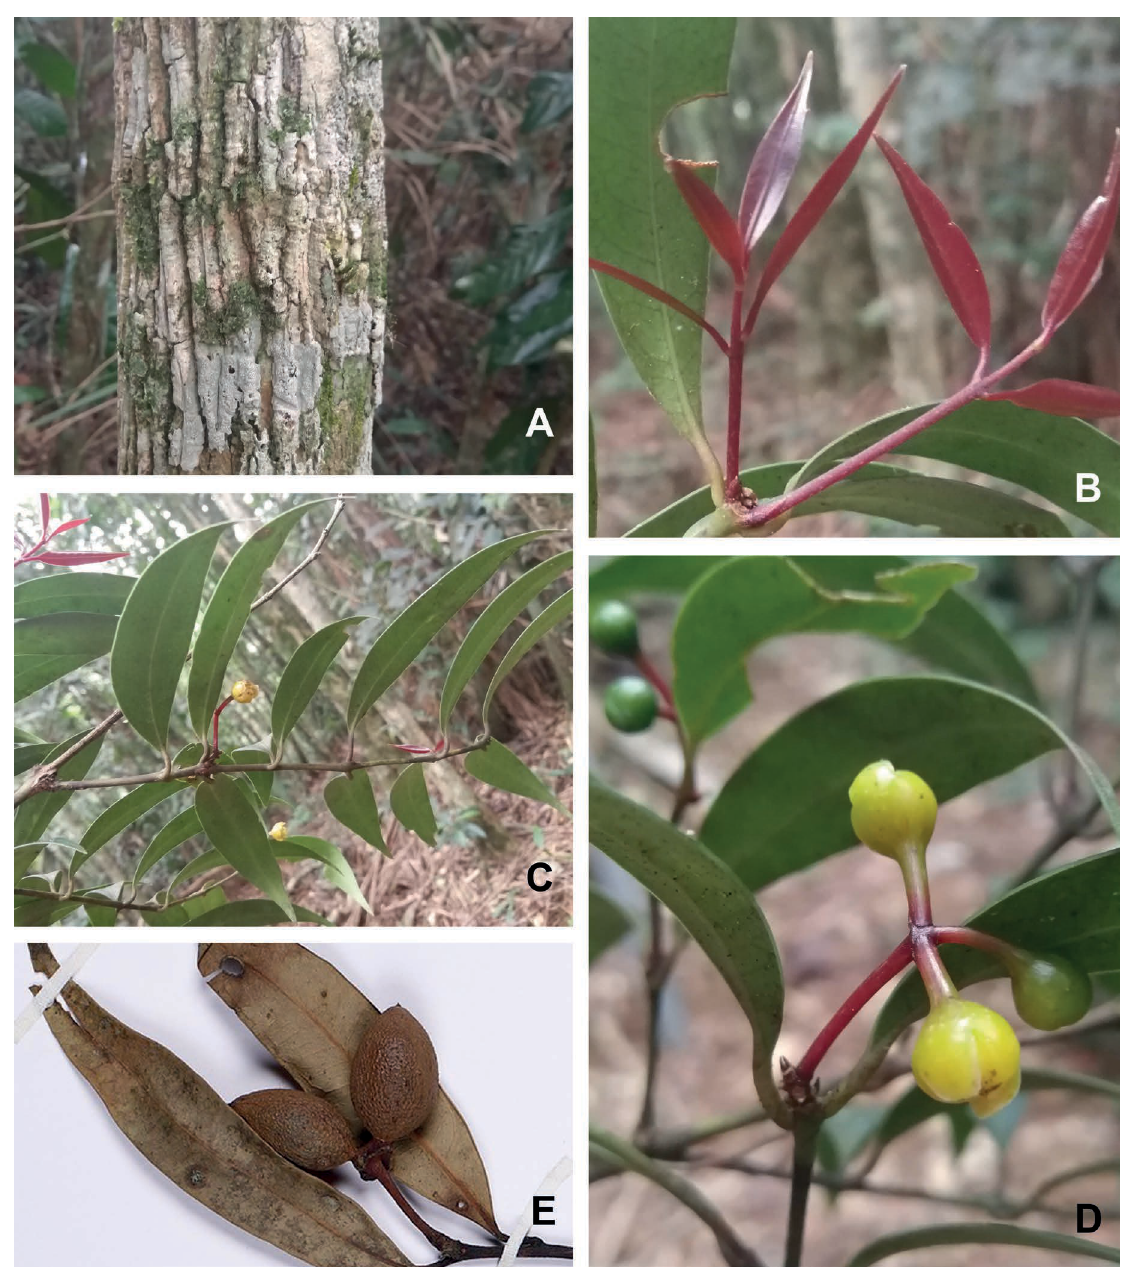
Figure 2 – Mollinedia ruschii . A . Trunk. B . Young branch. C . Branch with staminate flowers. D . Detail of staminate inflorescence. E . Fruiting receptacle with drupelets. A–D from E.J. Lírio & M.R. Neto 1548 ; E from L.J. Kollmann 2302 (RB). Photographs by Elton J. de